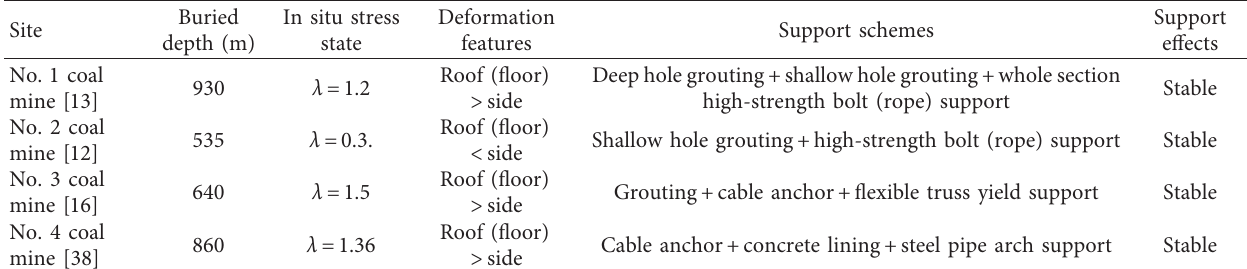
Figure 9: Effect of Young’s modulus attenuation on the response curve between surrounding rock and support. Soft rock, λ � 1.2, v � v � 0 . 2, and β � 3. (a) The curve at side position (0 ° ). (b) The curve at roof position (90 ° ). r r Table 3: Summary of cases on fracture and support scheme of opening under nonuniform